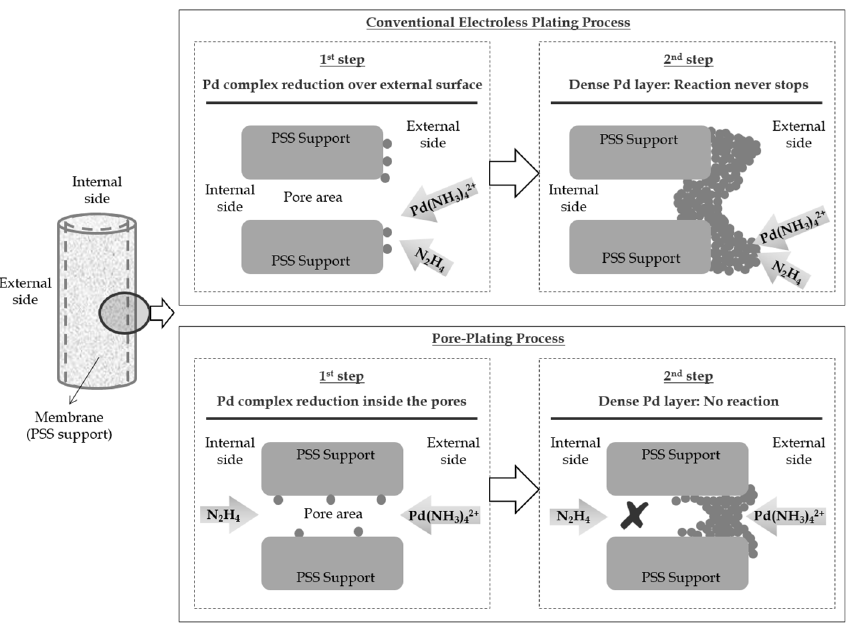
Figure 7. Pd incorporation around pores in both conventional electroless plating (ELP) and pore-plating (ELP-PP) alternatives [185], with permission from © Elsevier.